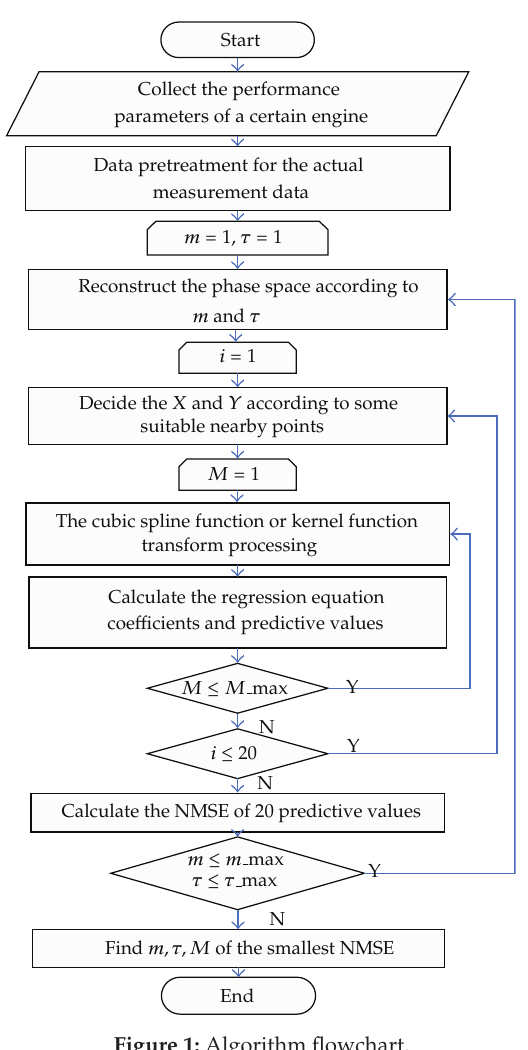
Figure 1: Algorithm